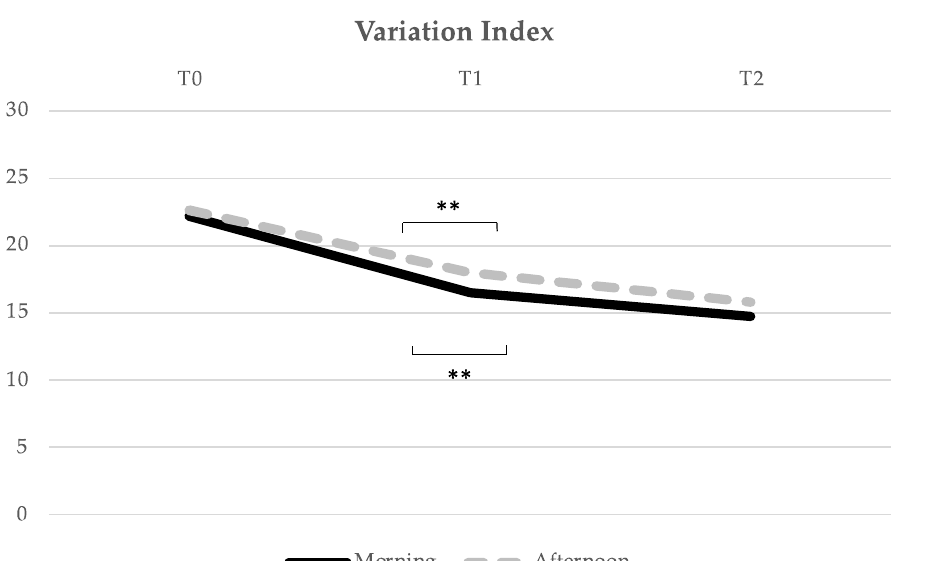
Figure 5. Evolution of the Variation Index mean score over time (from T0 to T1, i.e., from pre- to post-acute exercise; and from T1 to T2, i.e., from post-acute exercise to post-chronic exercise). ** Indicates significant differences for p < 0.01. Table 2. Independent samples t -test: Comparison of the 2 groups (M vs. A) in the Relative Ameliora- tion Scores (T1-T0; T2-T1;